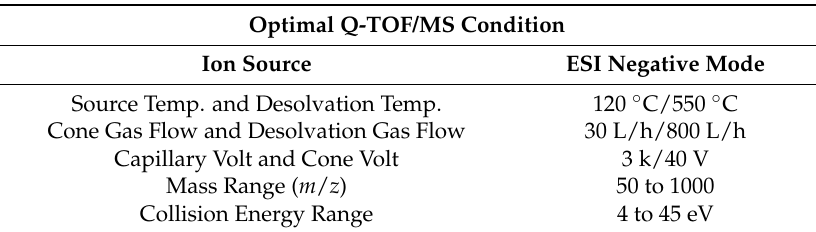
Table 3. Optimal conditions for the Q-TOF/MS analysis of HPGL